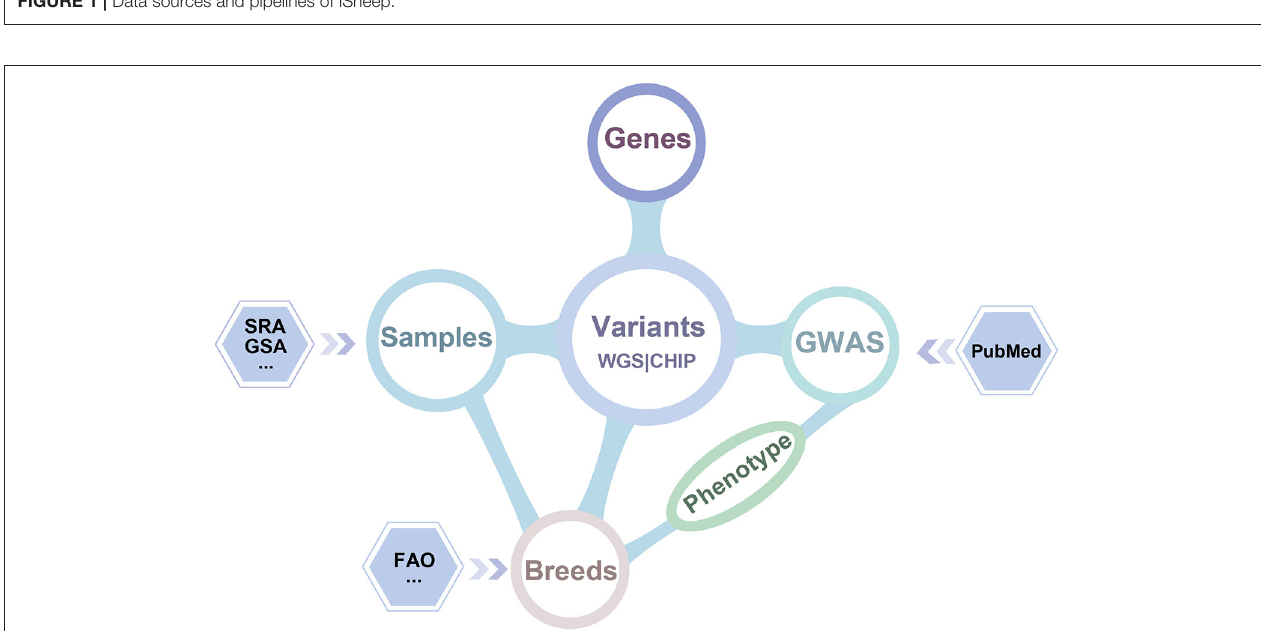
FIGURE 2 | Dataset relationship of iSheep. The iSheep integrates multiple types of data set with inter-connections between each other: ( i ) The Variants called from 355 samples’ whole genome sequence data and 2,423 samples’ chip data which have been deposited in Genome Sequence Archive (GSA) and Sequence Read Archive (SRA); ( ii ) Genes with variation annotation; ( iii ) GWAS dataset containing manually curated publications of genome-wide variant-trait associations in specific breeds; ( iv ) The sample information and corresponding breed information.